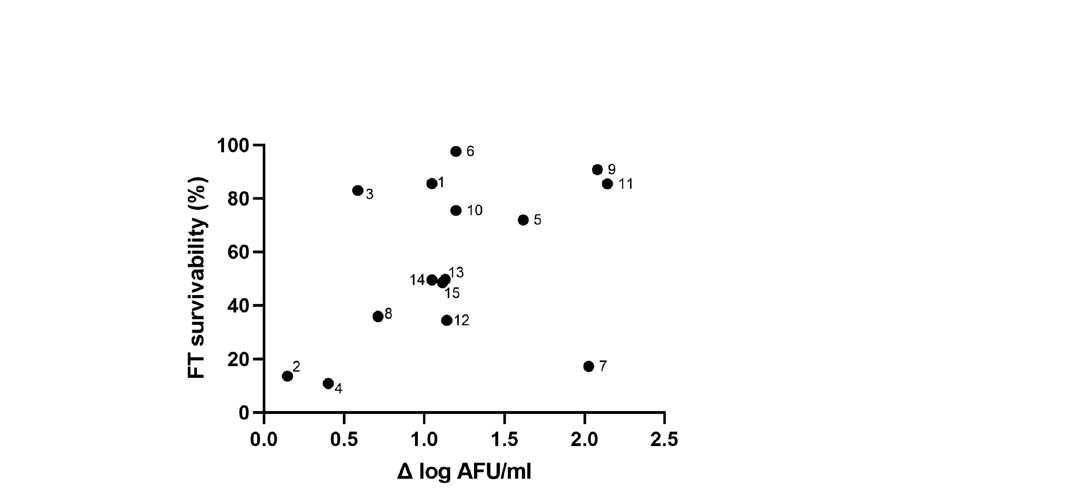
Figure 5. Freeze–thaw (FT) survivability (%) plotted against growth (Δ log AFU/ml). FT survivability (%) is calculated as a ratio of viability of cells after FT stress to viability of cells at harvest. (Correlation coefficient r = 0.4291, p-value >